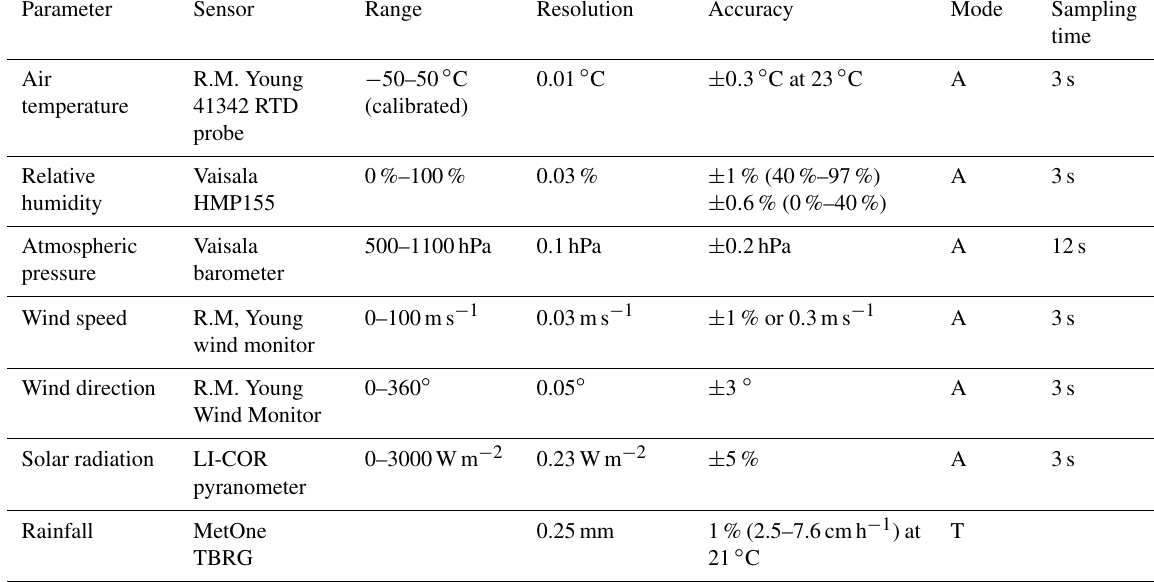
Table 2. Oklahoma Mesonet instrumentation (Mcpherson et al., 2007).